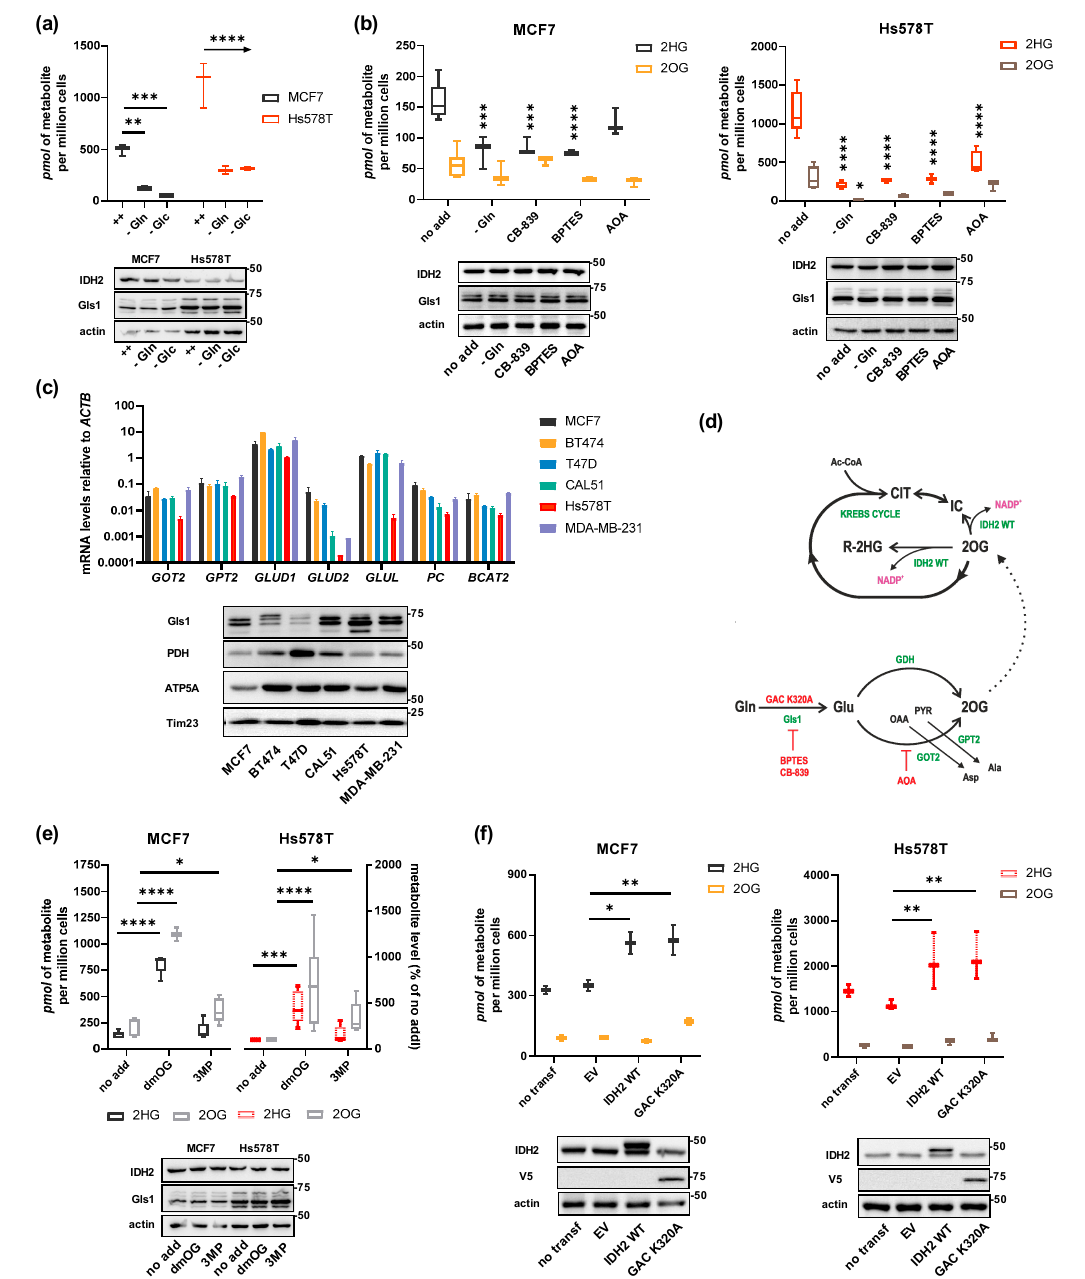
Figure 2. Substrate flux regulates 2HG mitochondrial production. ( a ) 2HG decline in MCF7 and Hs578T cells in glucose and glutamine-free media, respectively. n = 3. Two-way ANOVA. ( b ) 2HG and 2OG production after treatment o/n with inhibitors of glutaminolysis, i.e., CB-839 (5 µ M), BPTES (10 µ M), (Aminooxy)acetic acid hemihydrochloride (AOA, 500 µ M). n > 3. Two-way ANOVA. Western blots depict the expression of IDH2 and Gls1 in parallel samples. ( c ) Quantification of the expression level of genes related to 2HG production measured by qPCR. Gls1 expression assessed by western blot. Expression of mitochondrial markers pyruvate dehydrogenase (PDH), ATP synthase F1 subunit alpha (ATP5A), and mitochondrial import inner membrane translocase subunit Tim23. ( d ) Scheme depicting the glutaminolysis pathway and manipulations used in the experiments. ( e ) 2HG production after addition of dmOG (2 mM, 6 h) and 3-methylpyruvate (2 mM, 6 h) in MCF7 and Hs578T. n = 10. Two-way ANOVA. Western blots depict the expression of IDH2 and Gls1 in parallel samples. ( f ) 2HG and 2OG production in cells transfected with IDH2 WT and GAC K320A. n = 3. Two-way ANOVA. Western blots depict the expression of IDH2 and GAC (bearing V5-epitope) in parallel samples.* p < 0.05, ** p < 0.01, *** p < 0.001, **** p <